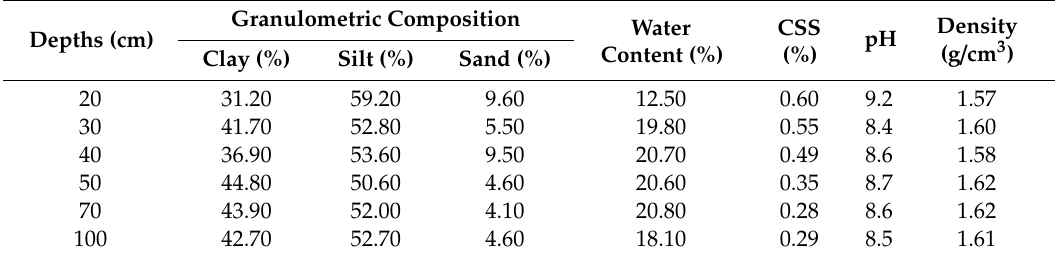
Table 1. Physical and chemical parameters of the original and disturbed soil samples.